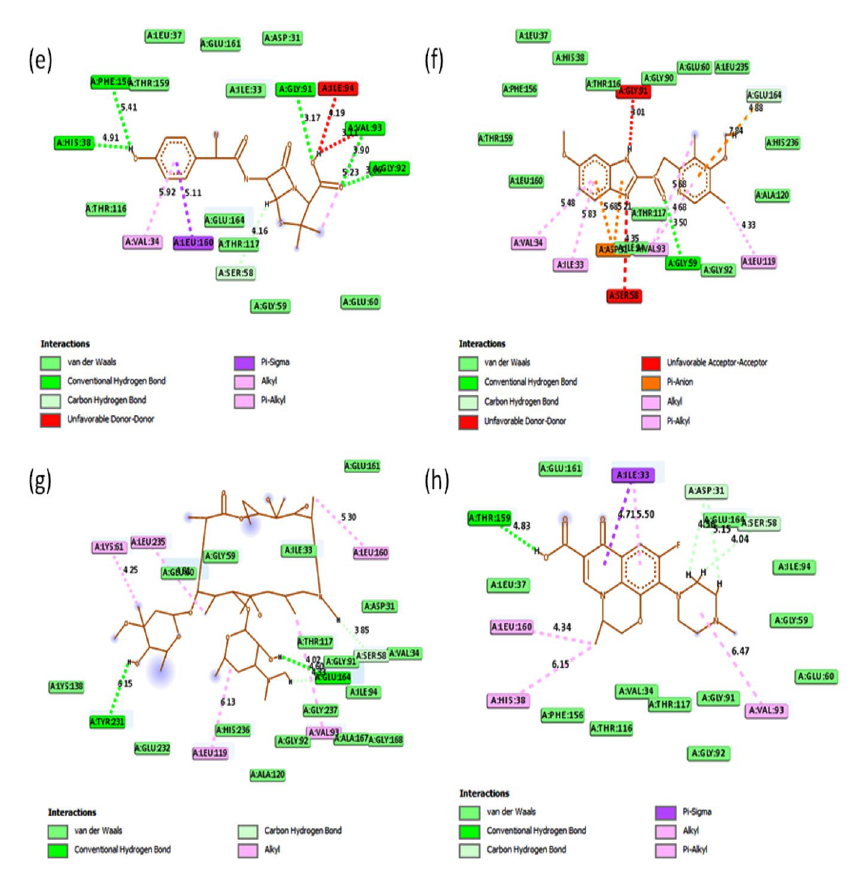
Fig. 2B. 2D interactions of compounds AMX, EMP, AZM and LEV with chorismate synthase PDB: 1UFM. 2D structures of the candidate drugs (e) Amoxicillin (AMX). (f) Esomeprazole (EMP). (g) Azithromycin (AZM). (h) Levofloxacin